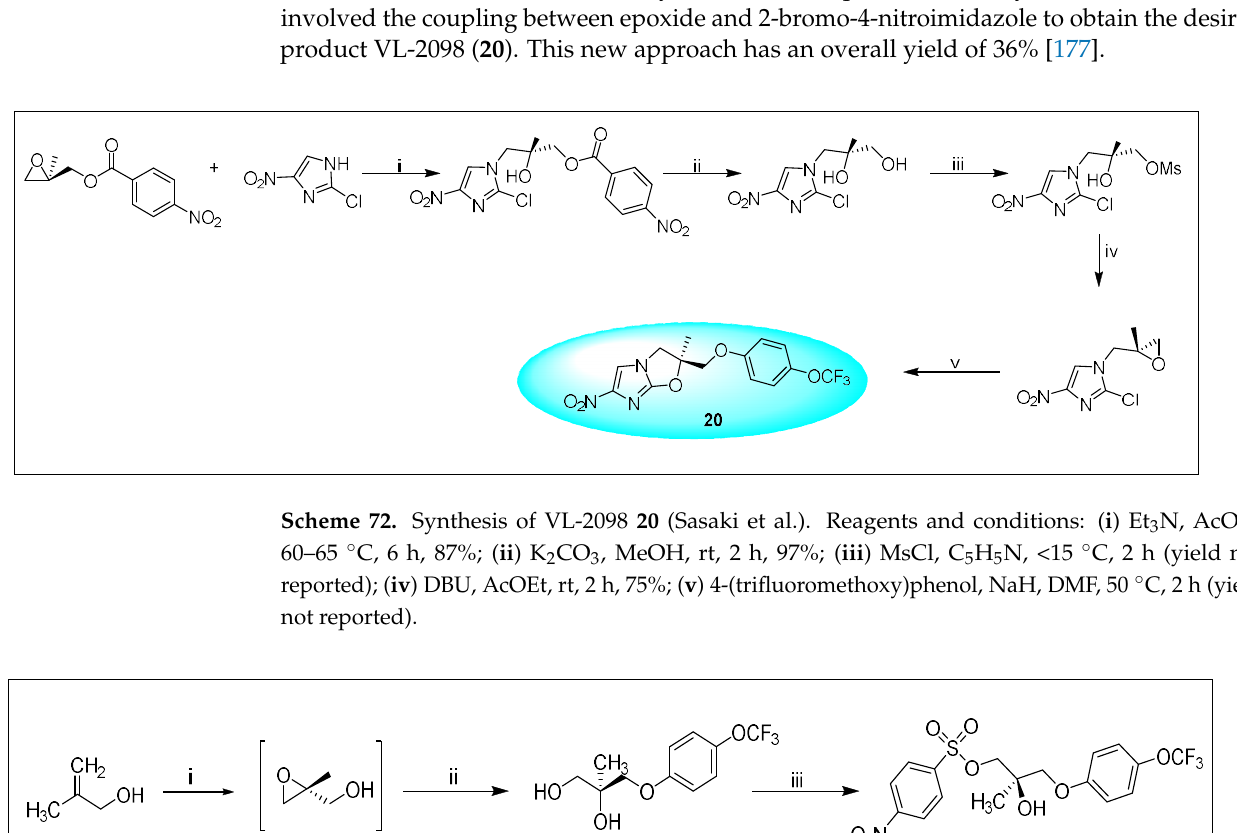
Figure 24. Activity profile of VL-2098 20